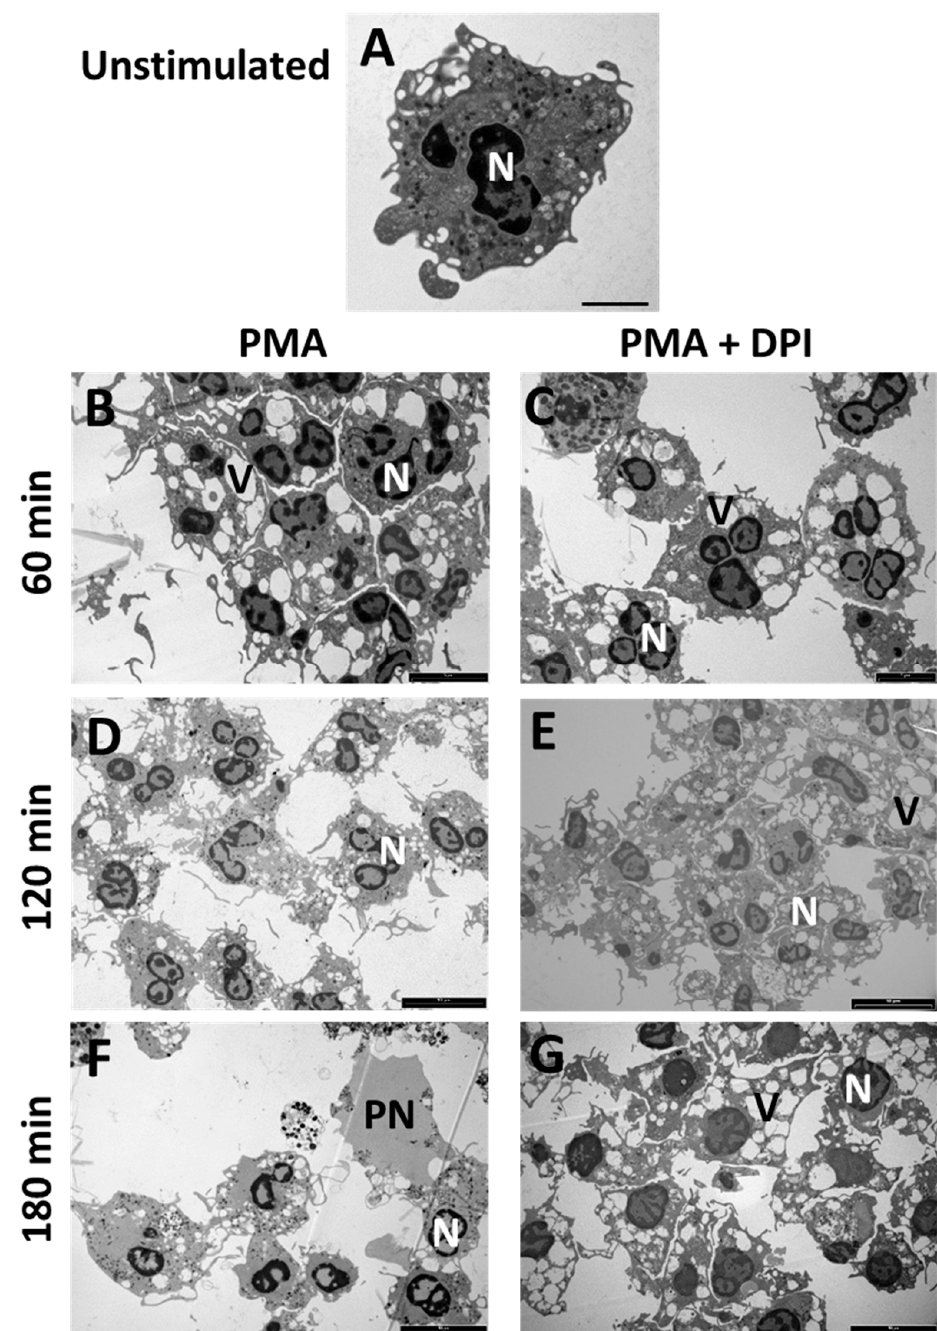
Figure 2. Transition electron micrographs showing morphology of PMA stimulated neutrophils in the presence or absence of DPI. ( A ) An unstimulated cell showing lobed nuclei and abundant cytoplasmic granules; ( B – G ) Neutrophils incubated with PMA for 60 to 180 min without ( B , D , F ) or with ( C , E , G ) DPI. Abbreviations: N = nucleus, V = vacuole, PN—pre-netting neutrophil. Results are representative of three separate experiments using different donors. Scale bars: ( A ) 2 µ m; ( B , C ) 5 µ m; ( D – G ) 10 µm.